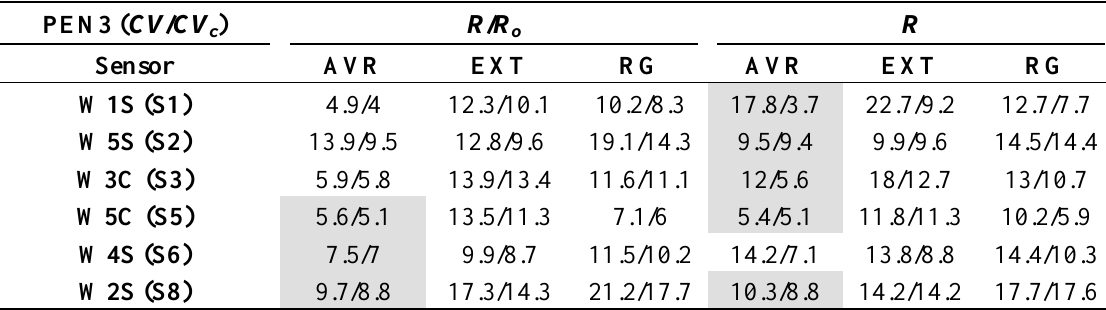
values for the sensors of c